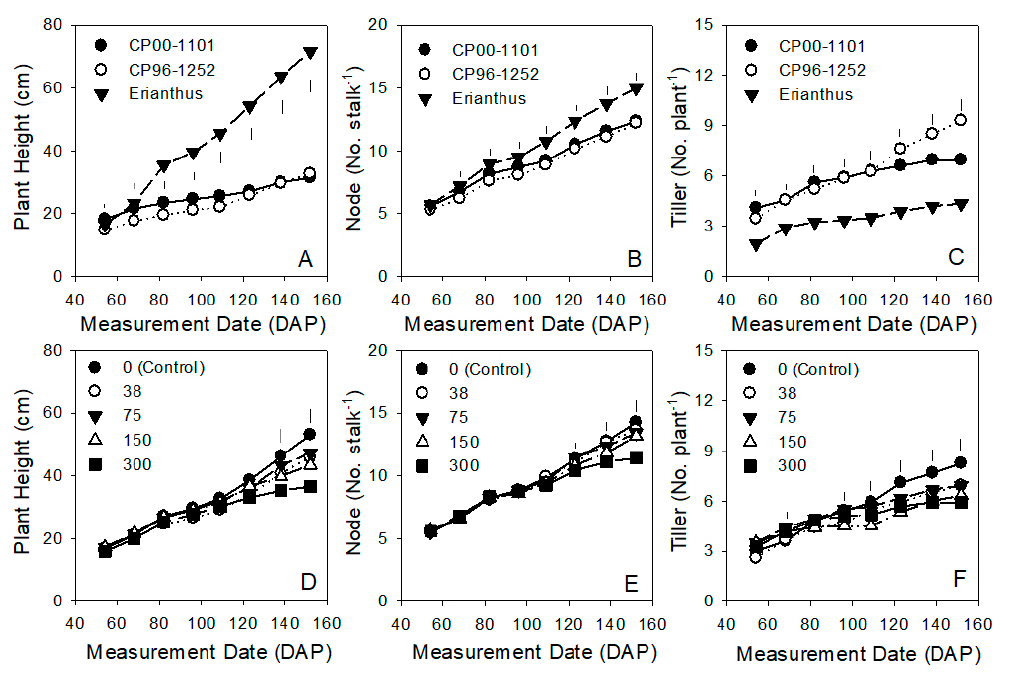
Figure 2. Plant height, the number of nodes measured on the primary stalk, and the number of tillers per plant for two sugarcane cultivars (CP 00-1101, CP 96-1252) and an Erianthus as affected by salinity treatments [0 (Control), 38, 75, 150, and 300 mM of NaCl added]. Vertical Bars indicate LSD 0.05 values if the main effects of ( A – C ) genotype or ( D – F ) salinity treatment are significant ( p ≤ 0.05) at a specific measurement time.